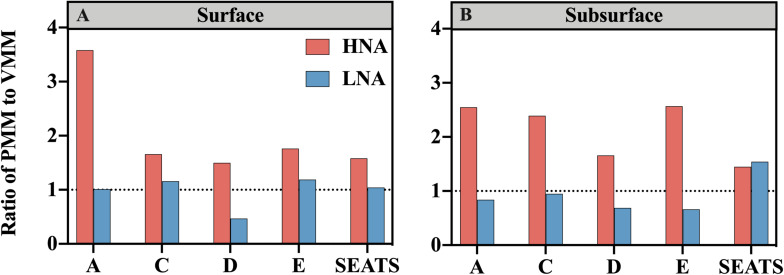
Ratios of protozoan grazing-mediated mortality (PMM) to viral lysis-mediated mortality (VMM) for the HNA subgroup (red bars) and LNA subgroup (blue bars) at stations along the transect at the (A) surface and (B) subsurface layers. The horizontal dashed line denotes the ratio of 1.